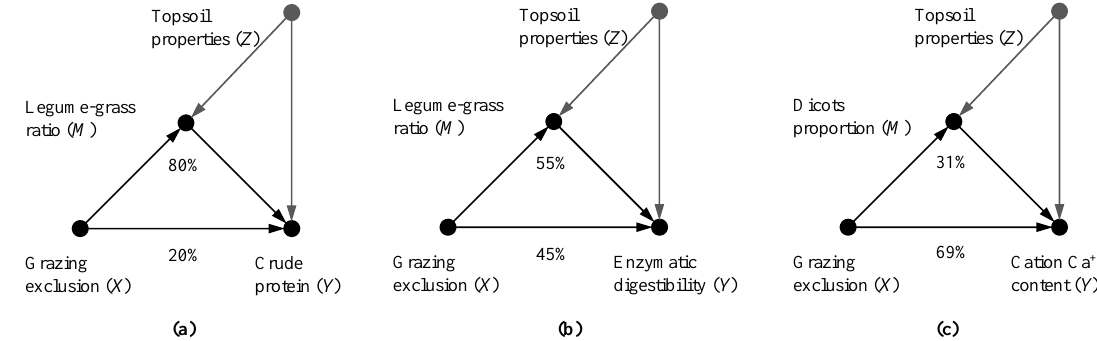
Figure 4. Direct (paths from X to Y ) and indirect effects (paths from X to Y passing through M ) of experimental grazing exclusion ( X ) on descriptors of forage nutritive quality ( Y ), once that topsoil properties ( Z ) have been taken into account. ( a ) Simultaneous change in the legume-to-grass ratio mediates 80% of change in crude protein content and, ( b ) 55% of change in enzymatic digestibility; ( c ) concurrent change in the proportion of dicots mediates 31% of change in cation calcium forage content.